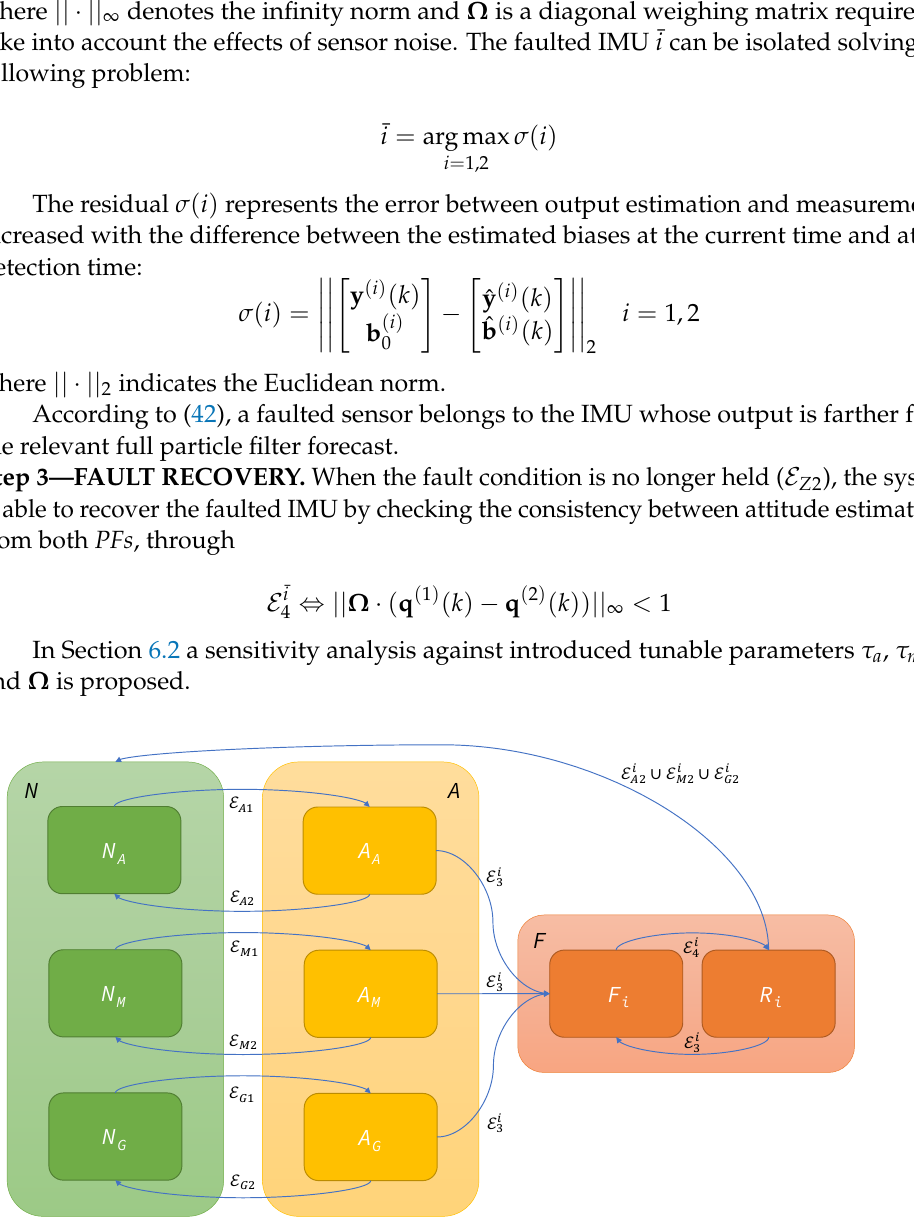
(cid:16) (cid:17) (cid:16) (cid:17) (cid:84) 2 (cid:84) 2 ∩ F i R i . Arrows denote event- i = 1 i = 1